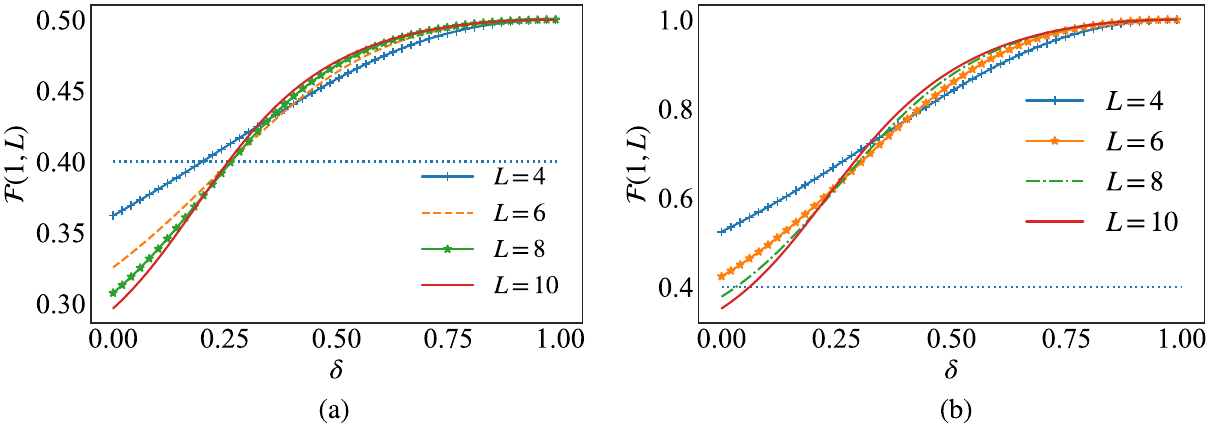
Figure 3. The fidelity, Eq. (9), with respect to δ for several chain sizes. In ( a ) Bell state projection are performed, while ( b ) consists of Hubbard projective